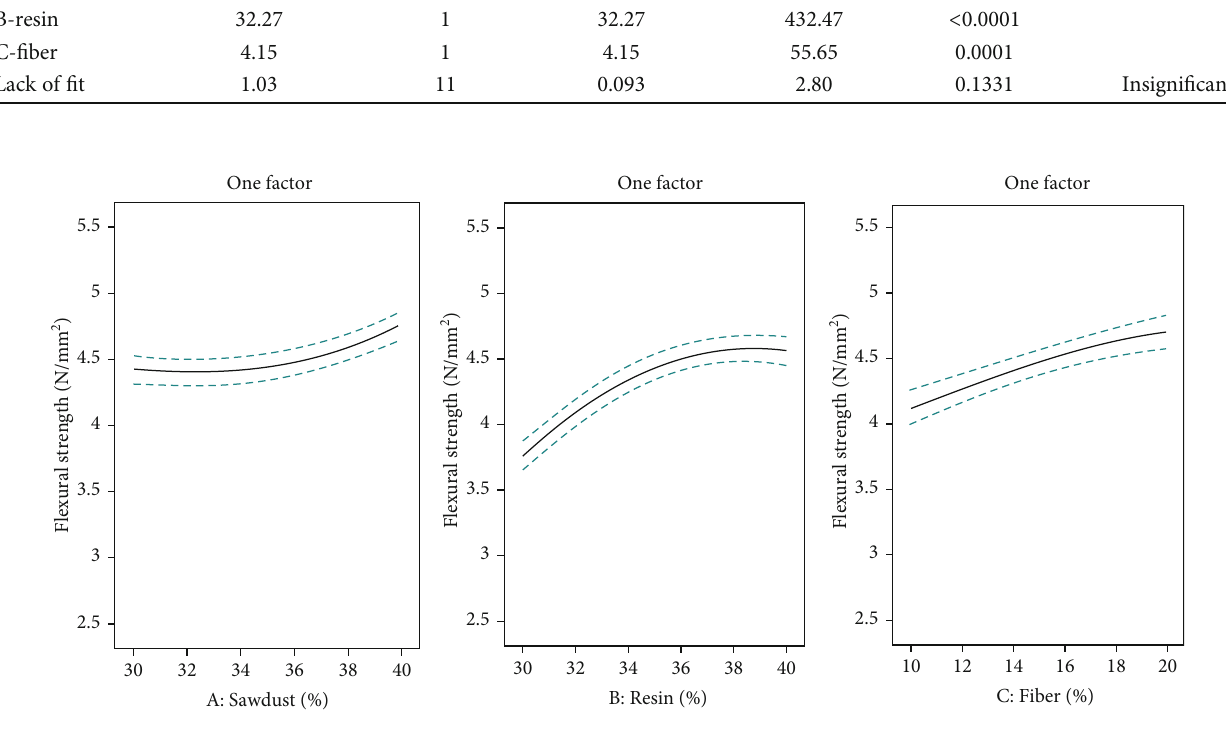
Figure 5: The e ff ect of factors on fl exural strength.